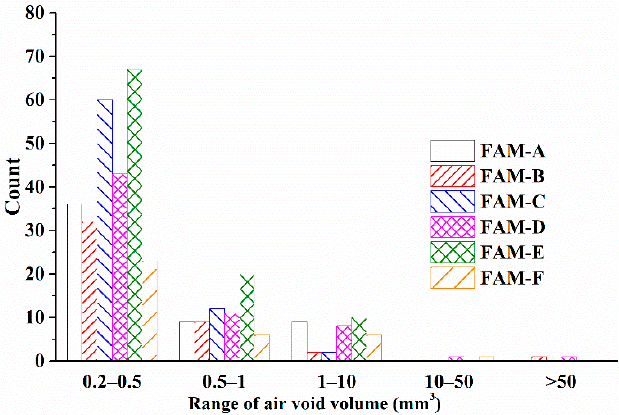
Figure 8. Volume distribution of air voids in FAM.